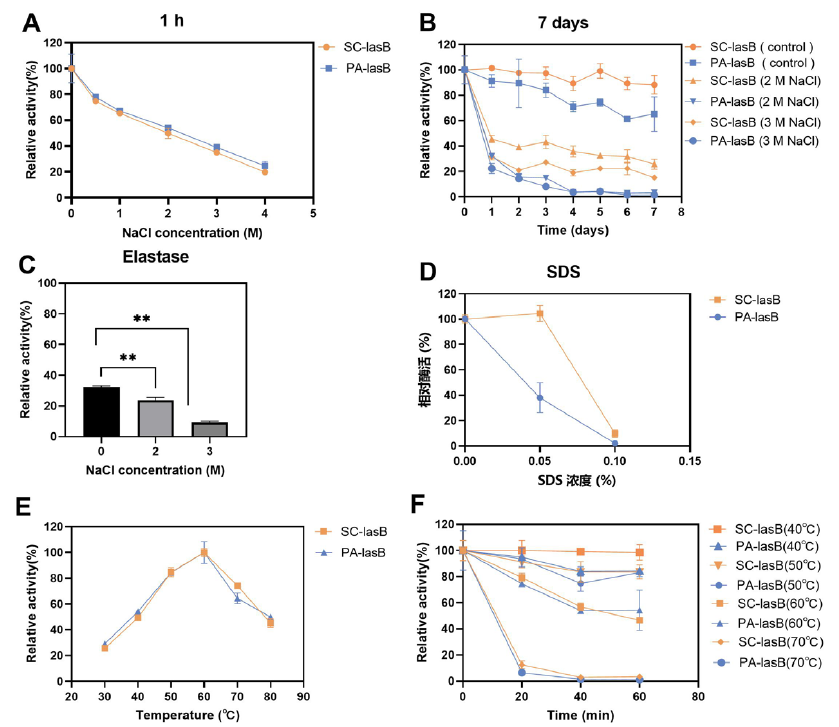
Figure 5. Assessment of the salt tolerance and thermal stability of SC-lasB and PA-lasB. ( A ) The relative activity after storage in 0–4 M NaCl for 1 h. ( B ) The relative activity after storage in 2 M and 3 M NaCl for 7 days. ( C ) The salt tolerance of elastase derived from porcine pancreas after storage in 2 M and 3 M NaCl for 7 days. ( D ) The relative activity after storage in 0–0.1% SDS for 1 h. ( E ) The optimal temperature curves of SC-lasB and PA-lasB. ( F ) The thermal stability of SC-lasB and PA-lasB. ** p < 0.01.